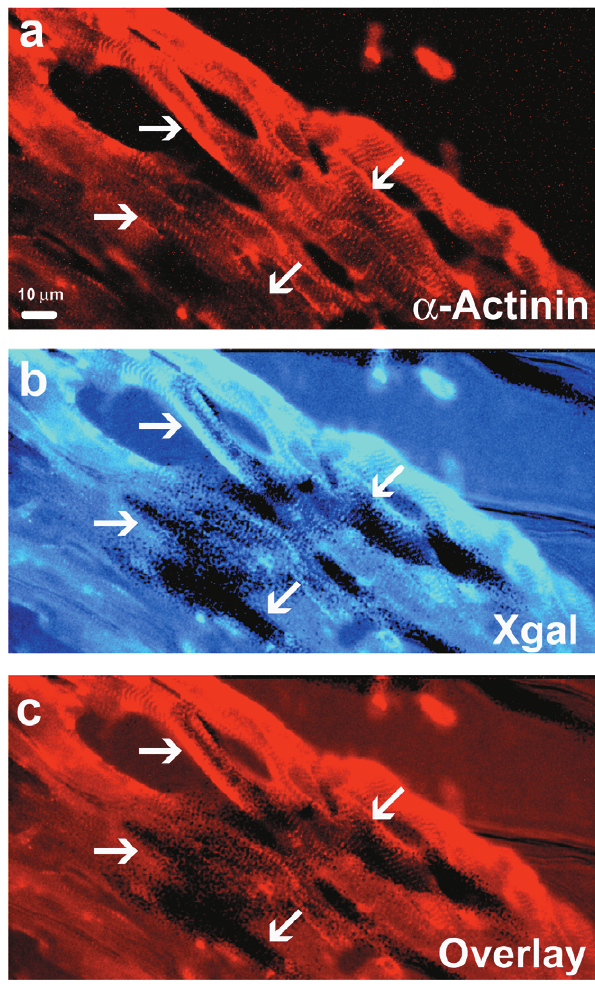
Figure 6. Co-localization of XGAL and sarcomeric a -actinin in LV cells of the adult mouse heart. Immunofluorescent staining for sarcomeric a -actinin in the adult mouse LV shows characteristic striations associated with cardiomyocytes (a, arrows). An adjacent serial section (10 m m) stained with XGAL shows dark (positive) staining, indicating a history of Pnmt gene expression (b, arrows). Overlay of the immunofluorescent and XGAL staining show a clear co-localization of cells that have a history of Pnmt expression and cells with a cardiomyocyte phenotype (c, arrows).